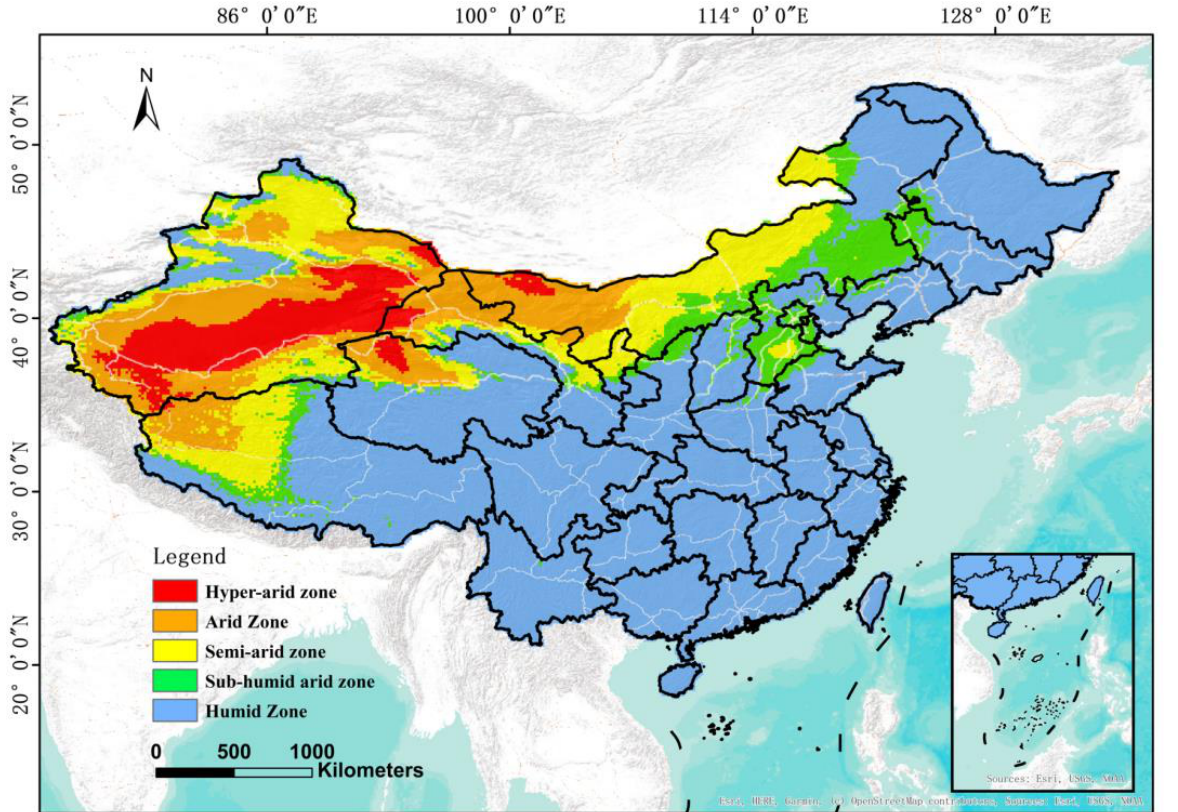
Figure 3. The study area. Divided into 5 climatic zones according to the moist index: MI less than 0.05 as the hyper-arid zone; MI between 0.05 and 0.2 as the arid zone; MI between 0.2 and 0.5 as the semi-arid zone; MI between 0.5 and 0.65 as the sub-humid arid zone; and MI greater than 0.65 as the humid zone.